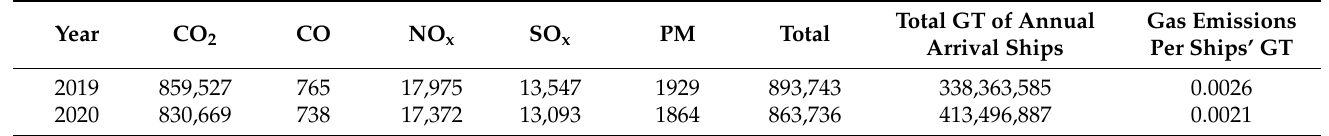
Table 7. Marine gas emission inventory in BP in 2019 and 2020.